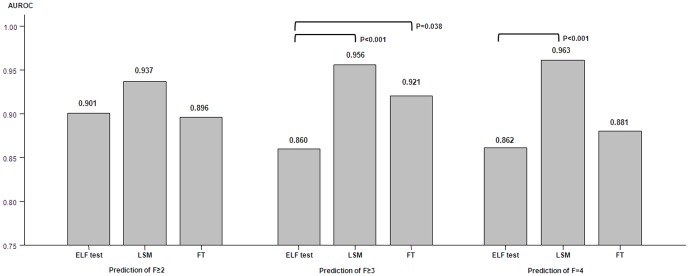
Detailed AUROCs of ELF test, LSM and FT in the diagnosis of significant fibrosis (≥F2), advanced fibrosis (≥F3), and cirrhosis (F = 4).